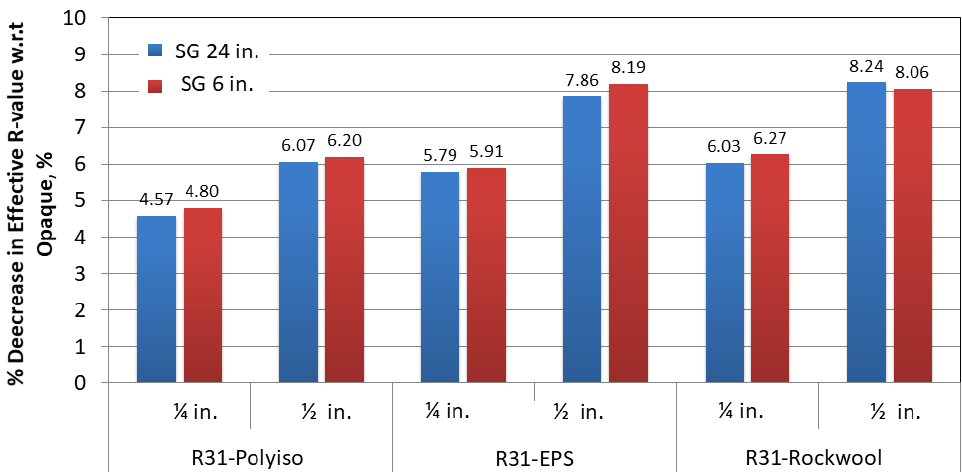
Figure 7. Effect of Joint Offset in Staggered Joint Configuration.